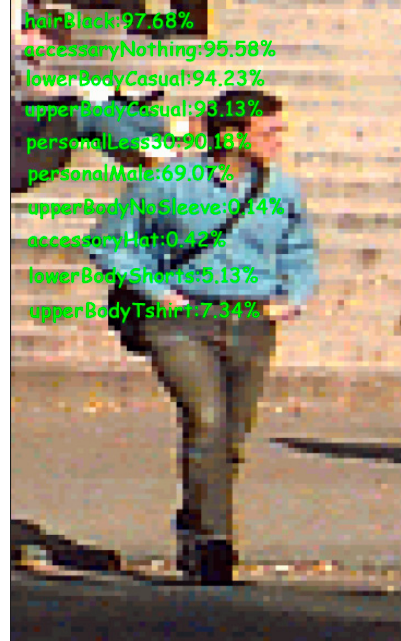
Figure 6. Recognition results of 10 attributes.